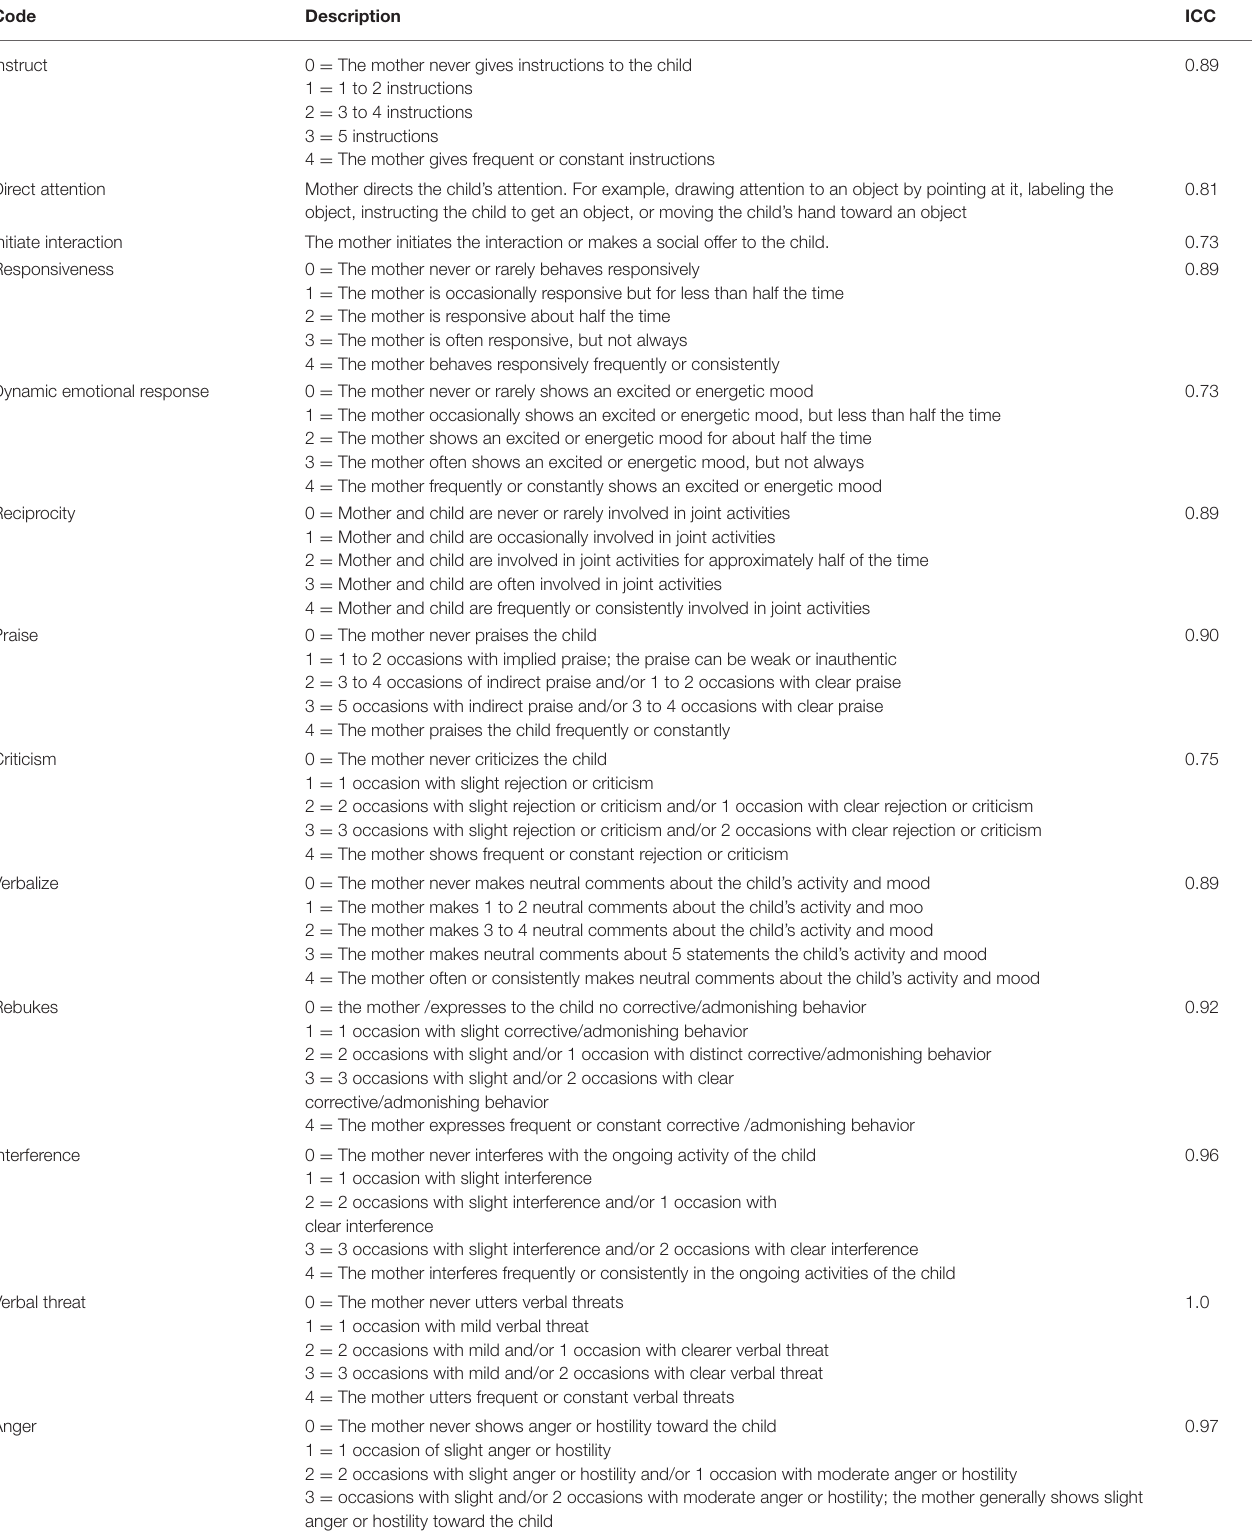
TABLE 1 | Coding scheme for maternal